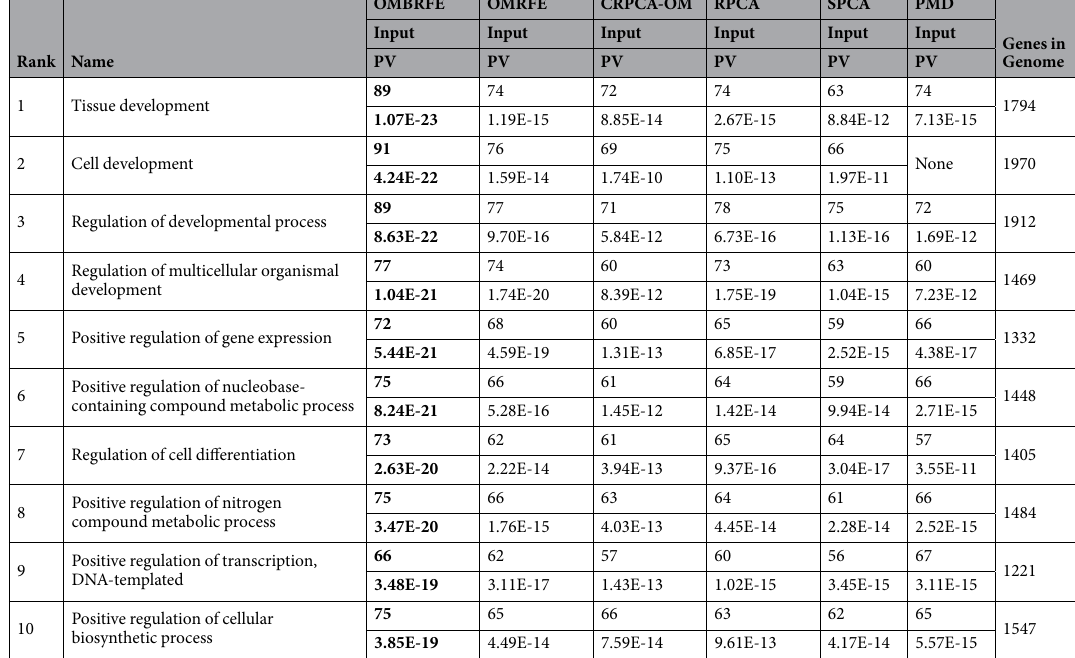
Table 1. The top 10 GO terms corresponding to genes identified by different